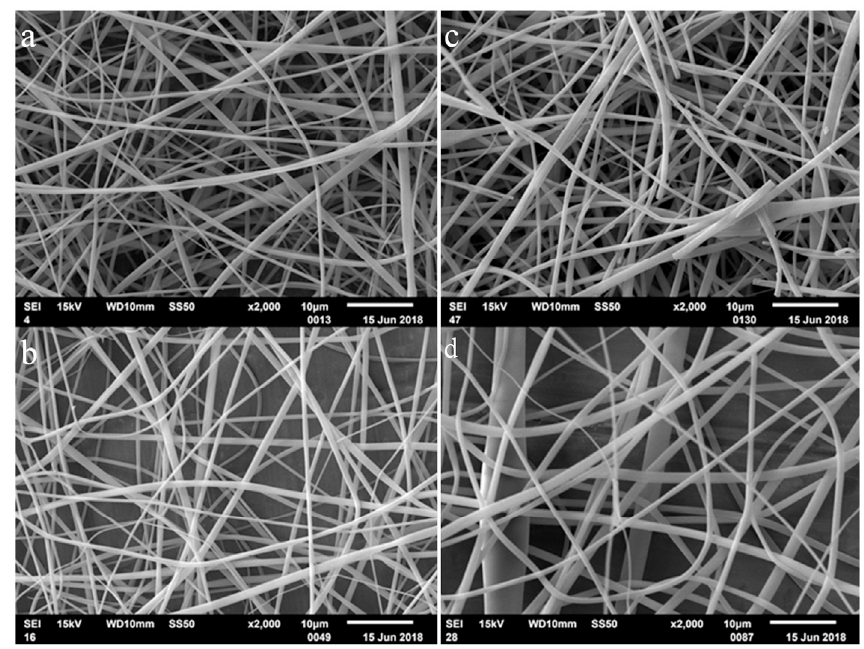
Figure 3. Comparison of SEM images of the ESP fibers obtained with increasing concentration in W/A mixture: 150% ( w/v) ( a ), 160% ( w/v) ( b ), 170% ( w/v) ( c ), and 180% ( w/v) ( d ) (0.1 mL/h, 25 kV, 13 W/A mixture: 150% ( w/v ) ( a ), 160% ( w/v ) ( b ), 170% ( w/v ) ( c ), and 180% ( w/v ) ( d ) (0.1 mL/h, 25 kV, cm NCD). 13 cm